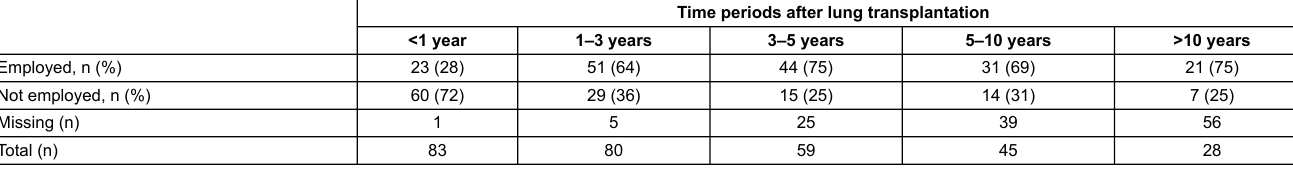
Table 2: Employment status for different time periods post lung